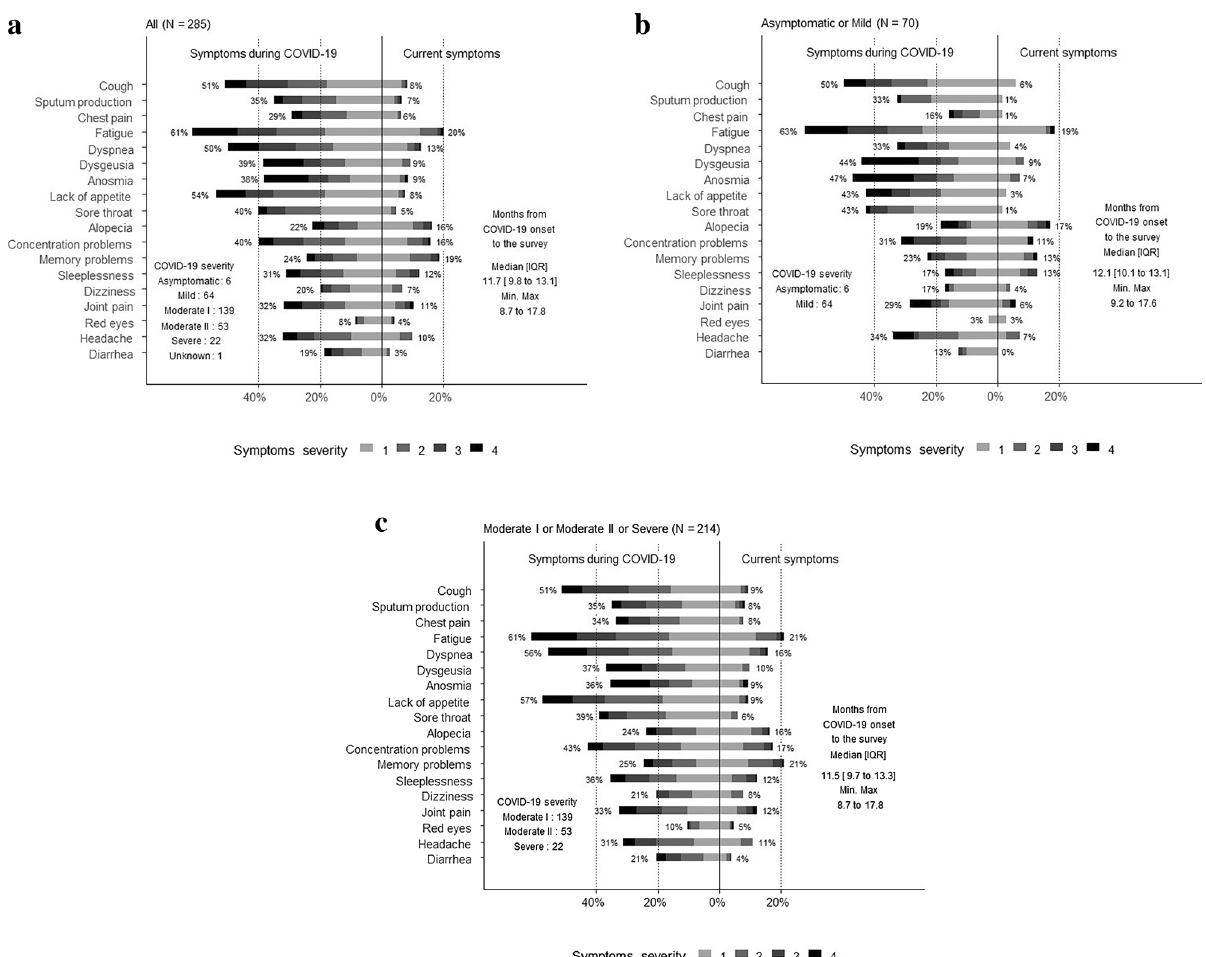
Figure 2. Distribution of each symptom in the acute phase and at the time of completing the questionnaire ( a ) All participants; ( b ) Mild group (asymptomatic and mild COVID-19 severity); and ( c ) Severe group (moderate I/II severity and severe